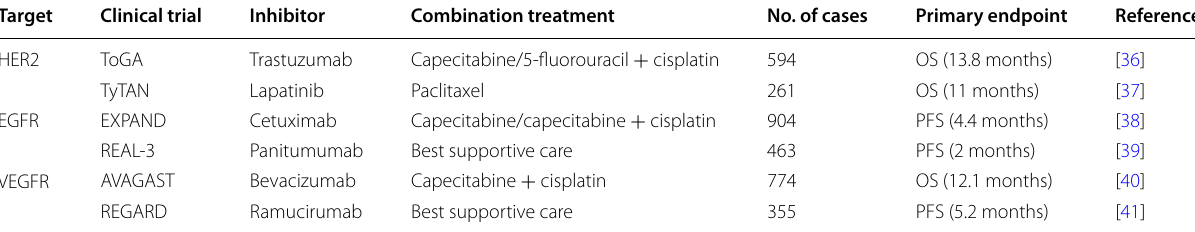
Table 2 Completed phase III clinical trials of targeted therapies for advanced